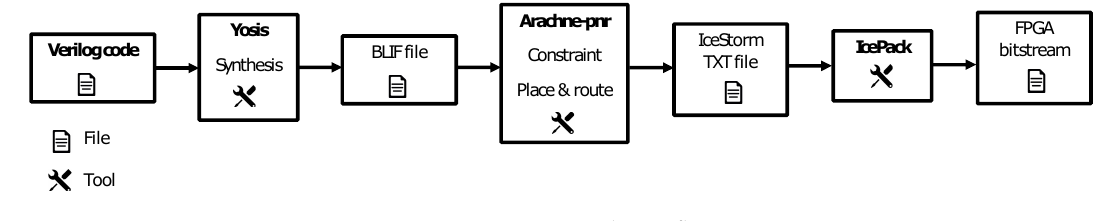
Figure 4. IceStorm design